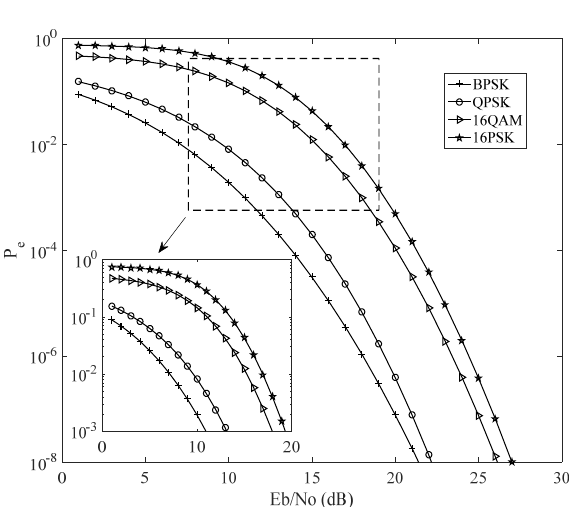
Figure 5. BER performance comparison between BPSK, QPSK, 16QAM and 16PSK.